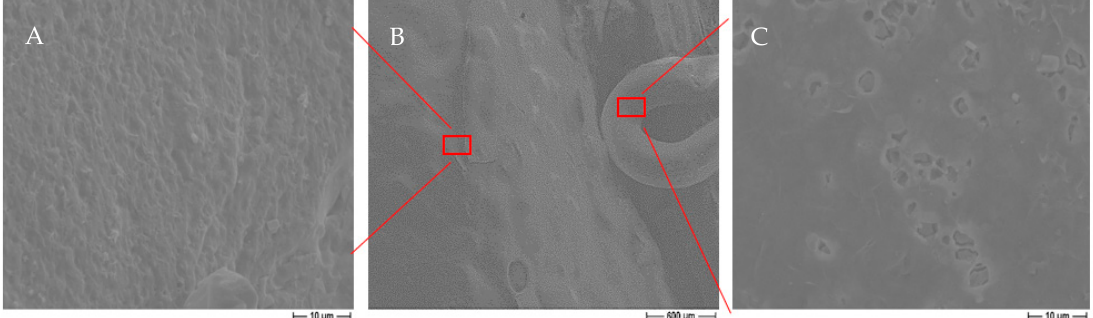
Figure 17. Micrographs of an Ag + -functionalized hybrid sca ff old. ( A , C ) are high magnification of image ( B ): polymer ( A ) and ceramic ( C ) parts indicate clean bacterial free surfaces.